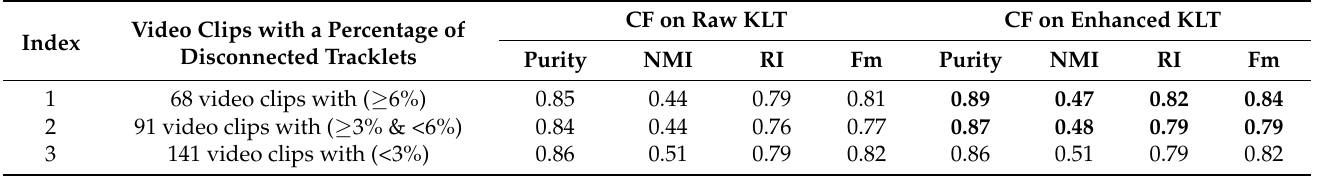
Table 3. Average experimental results (for 300 video clips) with Purity, NMI, RI, and Fm on the CUHK crowd dataset.